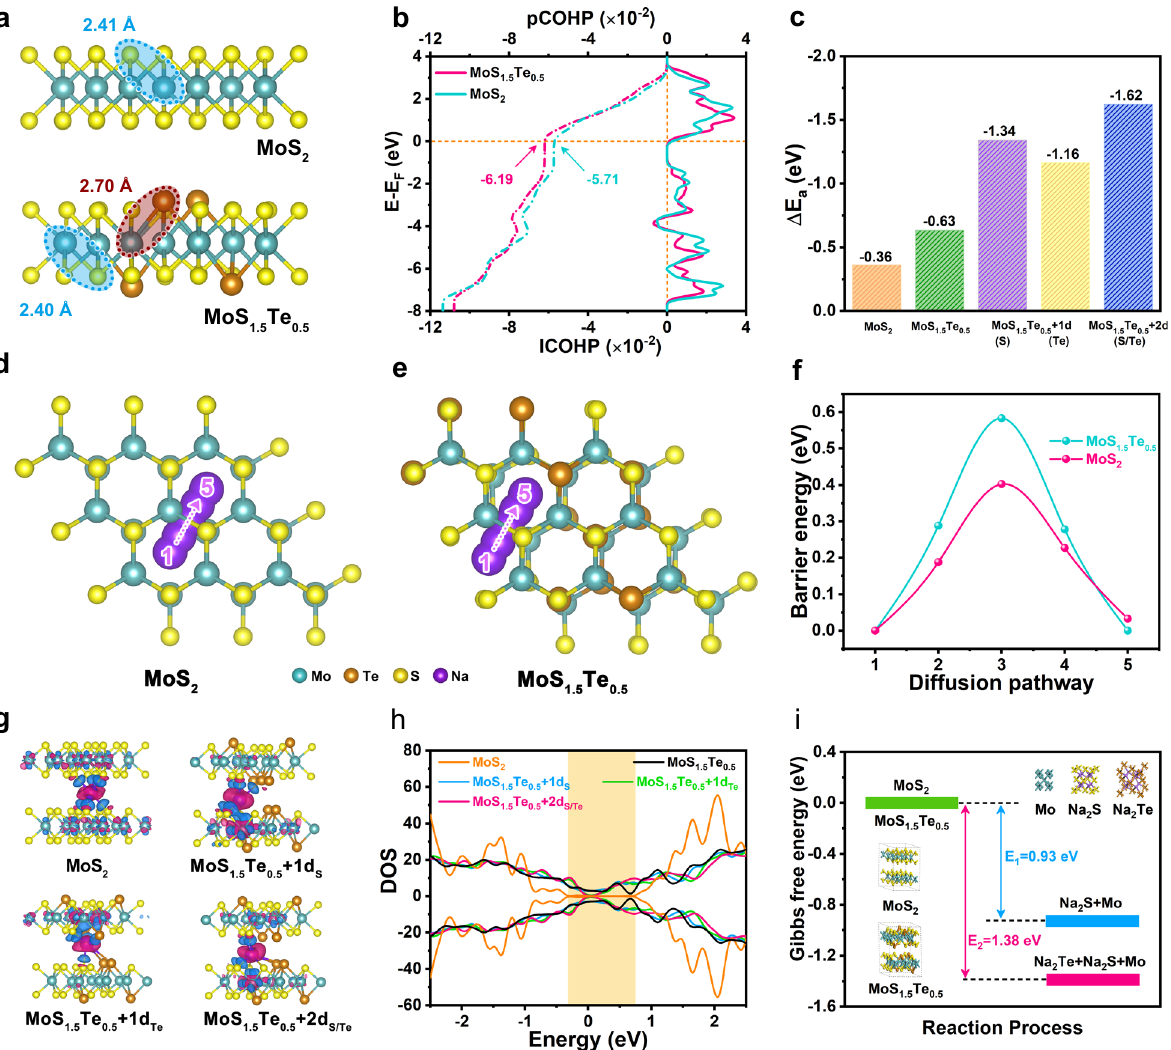
Fig. 6 Theoretical calculation and analyses for the Te doped MoS 2 . a The optimized structures of MoS 2 and MoS 1.5 Te 0.5 . b Average pCOHP and the corresponding integral patterns for MoS 2 and MoS 1.5 Te 0.5 . The pCOHP is the projected crystal orbital Hamilton population. The ICOHP is the integrated COHP. c The adsorption energy ( Δ E a ) for sodium storage in all calculated models of anodes. d , e Schematic illustration for the diffusion path of a Na atom in the MoS 1.5 Te 0.5 and MoS 2 , and f corresponding diffusion energy barrier curves. g Electron density differences of intercalated Na in MoS 2 , MoS 1.5 Te 0.5 , MoS 1.5 Te 0.5 with one S defect, MoS 1.5 Te 0.5 with one Te defect, MoS 1.5 Te 0.5 with one S defect and one Te defect structure. h Total density of states (DOS) of MoS 2 , MoS 1.5 Te 0.5 , MoS 1.5 Te 0.5 with defects. i Free energy diagrams for the intercalation reaction and conversion reaction of MoS 2 and MoS 1.5 Te 0.5